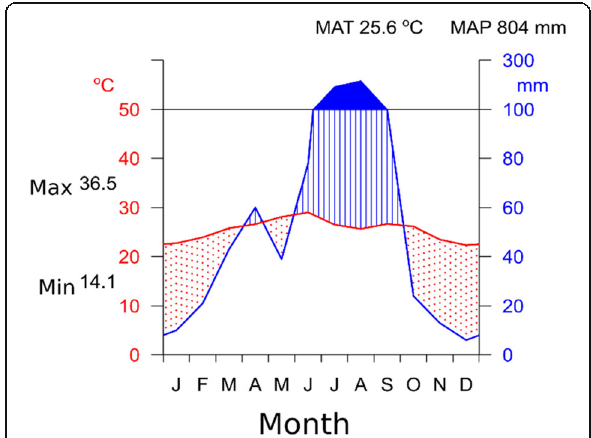
Fig. 2 The climate diagram of the study area (values generated using New_LocClim). The red and blue lines show the temperature curve and annual precipitation time series, respectively. MAT, mean annual temperature; Max, maximum absolute temperature; Min, minimum absolute temperature; MAP, mean annual